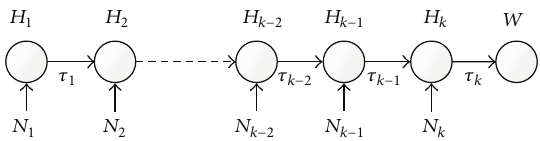
Figure 1: The bus line with multiple origins and a single